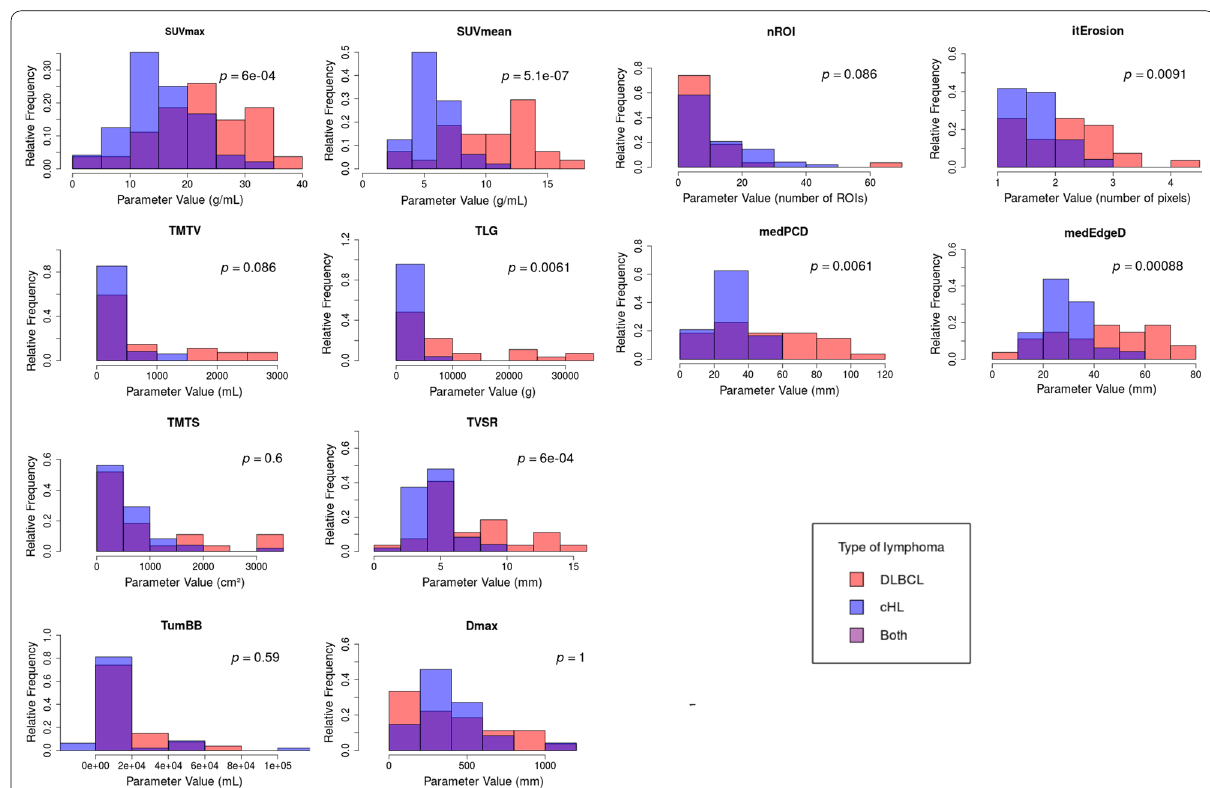
Figure 1 Plots representing distribution histograms of PET parameters fused for DLBCL and cHL with Wilcoxon–Mann–Whitney test p value